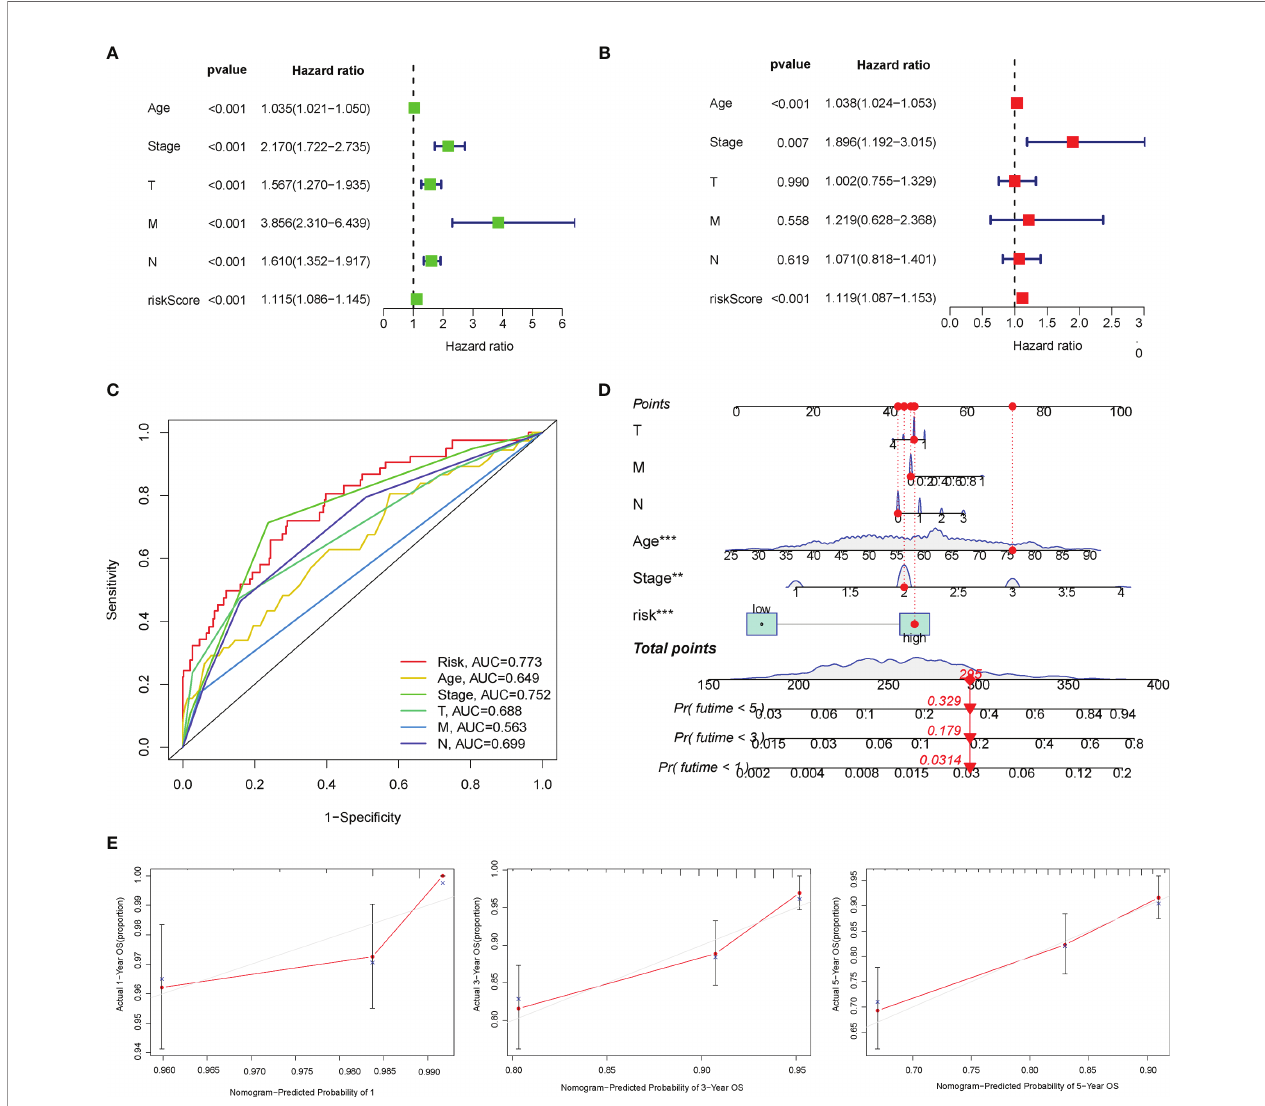
FIGURE 4 | Overall survival (OS)-related factors were screened through the univariate and multivariate Cox analyses, and the prognostic accuracy of risk score, age, stage, and TNM staging was compared. The univariate (A) and multivariate (B) Cox regression analyses of the risk score and other clinical feature prognostic values. (C) The prognostic accuracy of risk score, age, stage, and TNM staging was compared in 2 years using the time-dependent receiver operating characteristic (ROC) curve. (D) Construction of a nomogram containing the risk score, age, stage, and TNM staging to predict 1-, 3-, and 5-year OS of breast cancer (BC). (E) The calibration curve for the prediction and observed 1-, 3-, and 5-year